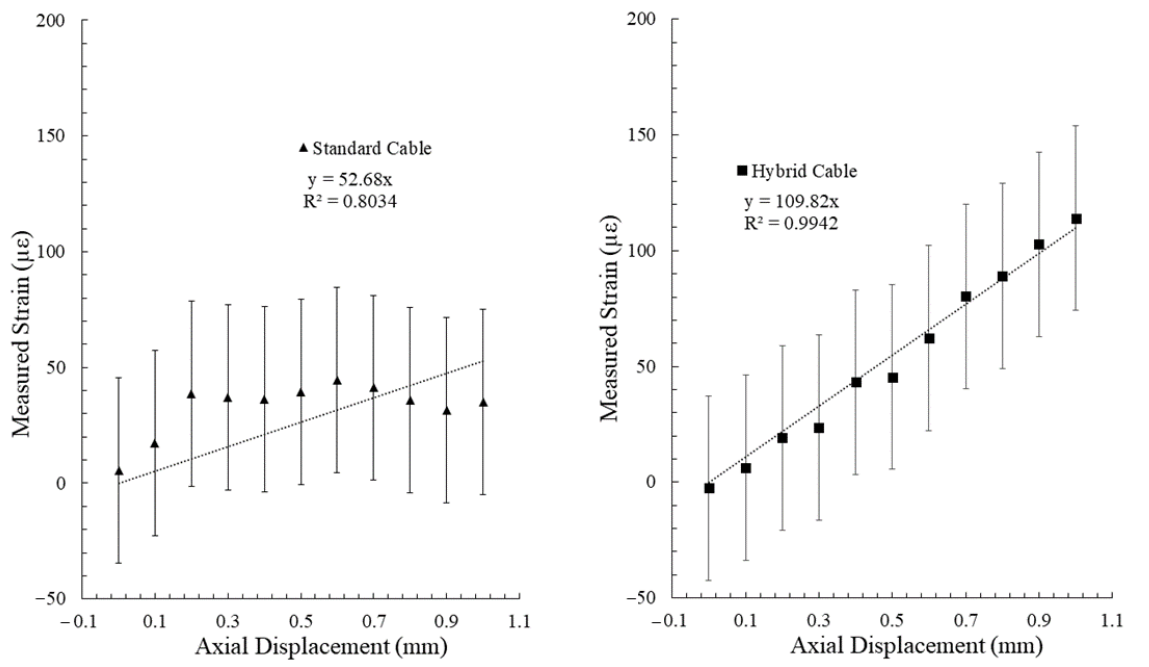
Figure 19. Measured strain verses applied axial displacement for a standard optical fiber cable ( left ) and the developed hybrid fiber optic cable ( right ).